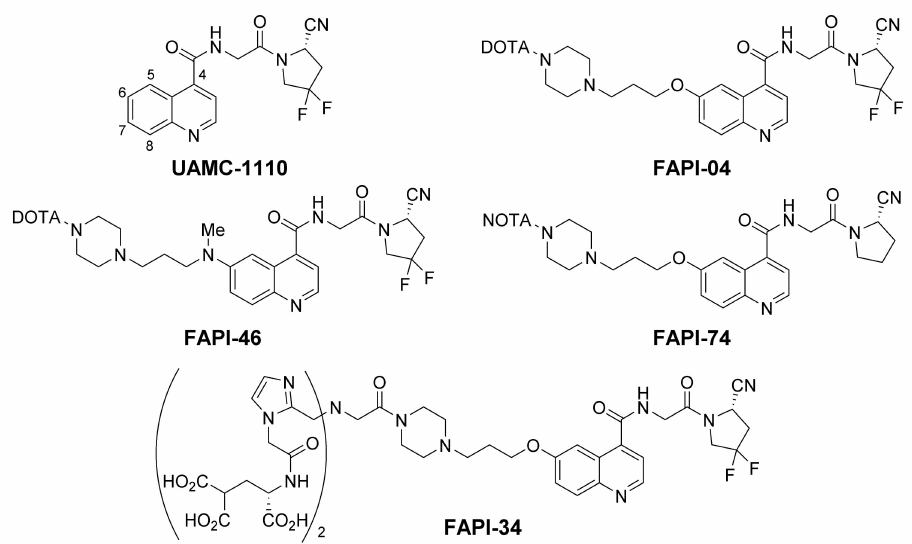
Figure 2. UAMC-1110, developed at the University of Antwerp, and various FAPI-tracers, developed by the Haberkorn group, based on this motif. FAPI-04 was the first theragnostic anti-FAP agent and is currently the most investigated tracer. FAPI-46 offers improved tumor retention and pharmacokinetics; FAPI-74 can be labeled with [ 18 F]aluminum fluoride or 68 Ga at ambient temperature; FAPI-34 is suitable for labeling with the theragnostic pair 99m Tc/ 186/188